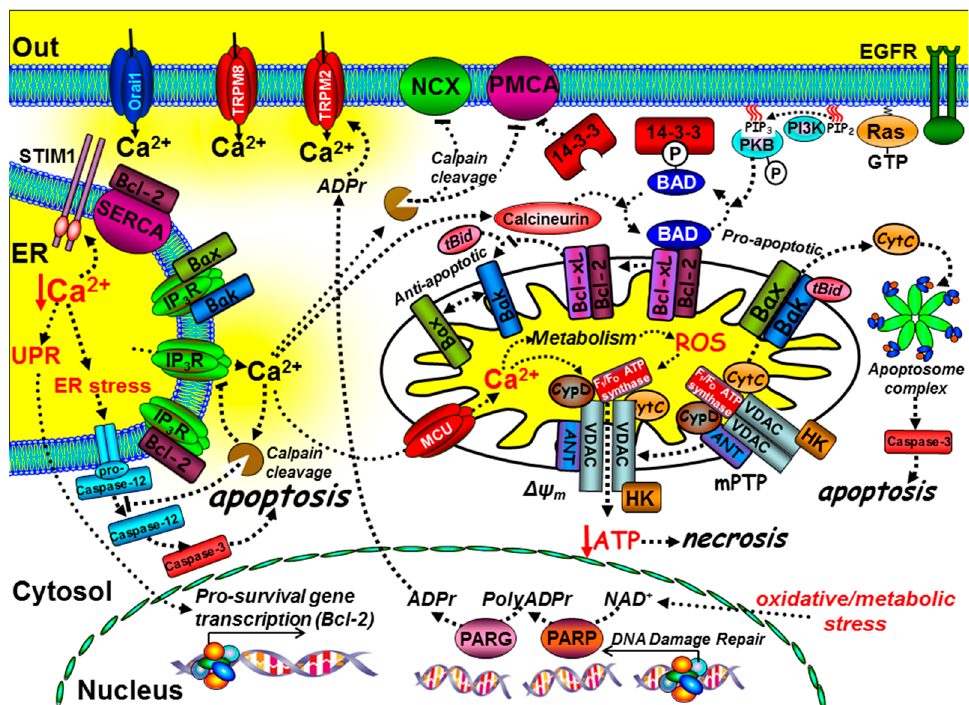
Figure 3. The role of key components of the Ca 2 + signalling machinery in cell death and immortality. Ca 2 + mediates intrinsic cell death at both the mitochondria and ER. At the mitochondria, tBid binds to and promotes Bax and Bak oligomerisation into pores that release cytochrome C, which binds to the apoptosome complex and activates the executioner caspases, such as caspase-3, leading to the “point-of-no-return” apoptotic cascade. The anti-apoptotic proteins, Bcl-2 and Bcl-xL, can prevent the t-Bid / Bax / Bak interaction, thereby preventing apoptosis. The pro-apoptotic protein Bad binds to Bcl-2 / Bcl-xL, thereby preventing their interaction with the t-Bid / Bax / Bak complex, thus promoting apoptosis. Phosphorylation of Bad, via growth factor receptor-mediated activation of protein kinase-B (PKB), causes Bad to dissociate from the mitochondria and bind to 14-3-3 protein. Sustained Ca 2 + overload can activate calcineurin, which dephosphorylates Bad, allowing it to sequester the anti-apoptotic proteins, Bcl-2 / Bcl-xL. Ca 2 + uptake into the mitochondria, via the mitochondrial Ca 2 + uniporter (MCU), can lead to the production of reactive oxygen species (ROS). Ca 2 + and ROS can activate the permeability transition pore (mPTP), loss of the mitochondrial membrane potential ( ∆Ψ m), ATP depletion and necrosis. Ca 2 + overload can also activate calpain and cleavage of the PMCA, Na + / Ca 2 + -exchange (NCX), and inositol 1,4,5-trisphosphate receptors (IP3Rs). Bax, Bak, and Bcl-xL can also bind to and inhibit IP 3 Rs. Bcl-2 can bind to and inhibit SERCA, reducing ER Ca 2 +